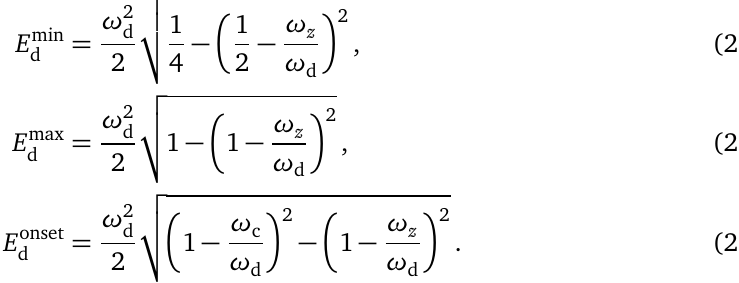
(b). z and c . The gray d and c